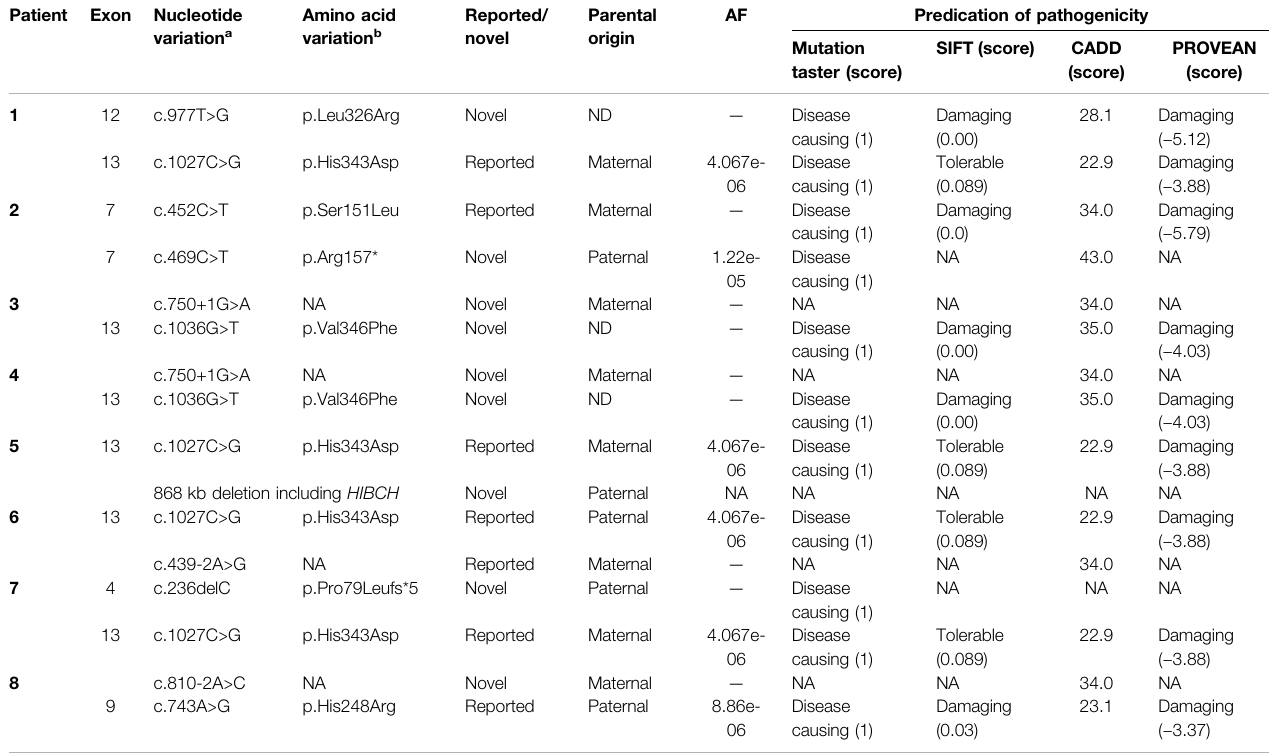
TABLE 1 | HIBCH mutations in eight patients. Patient Exon Nucleotide variation